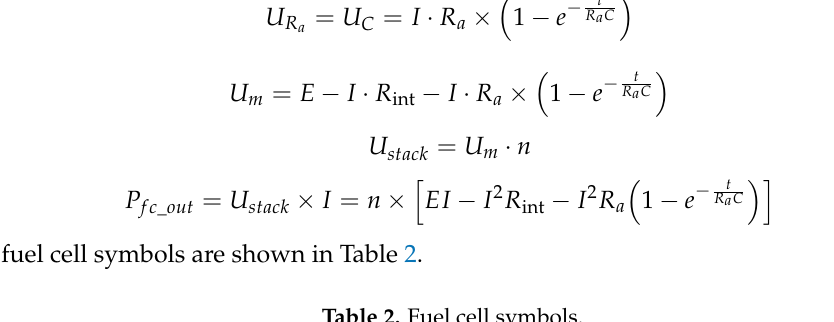
Table 2. Fuel cell symbols.